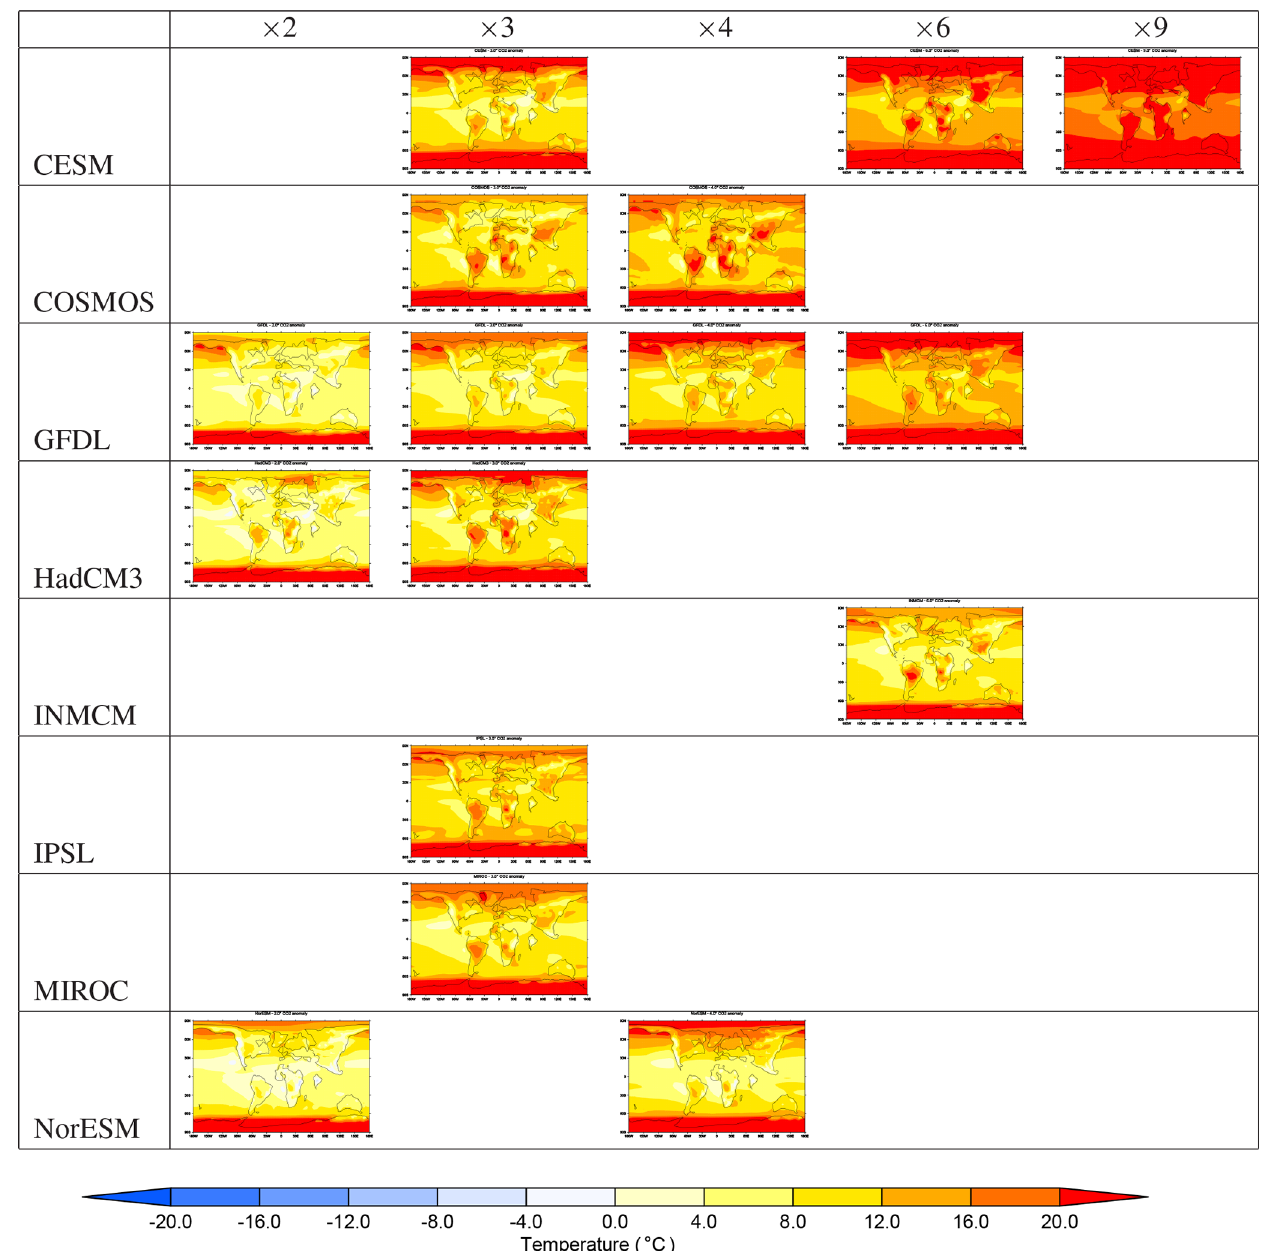
Figure 3. DeepMIP near-surface air temperature anomalies, relative to the zonal mean of the associated preindustrial simulation, ordered by CO 2 concentration and by model. Simulations with CO 2 equal or greater than × 2 are shown. The variable plotted is GAT m e − GAT m p in the notation of Lunt et al.